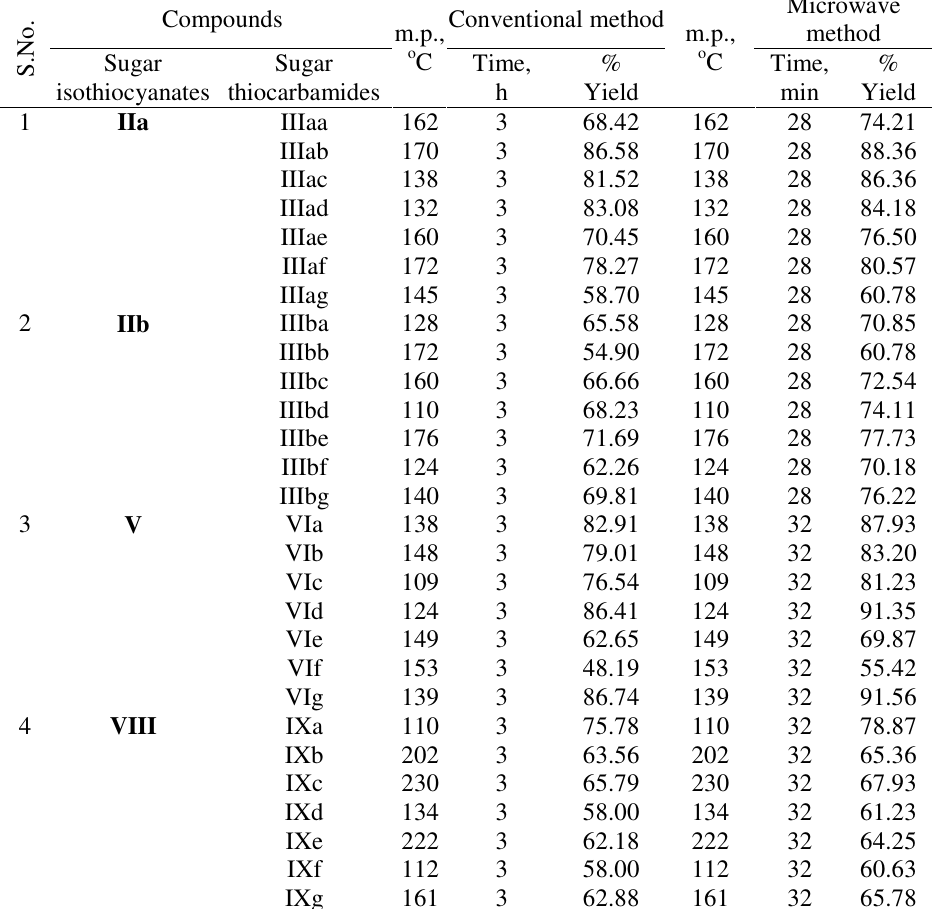
Table 2. Physical data of acetylated sugar thiocarbamides and comparative study of conventional vs . microwave